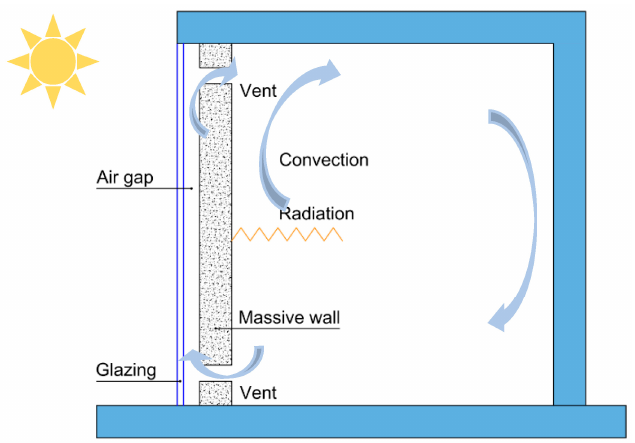
Figure 1. Operation principle of a classic Trombe wall, and energy gain. (adopted from [16]).